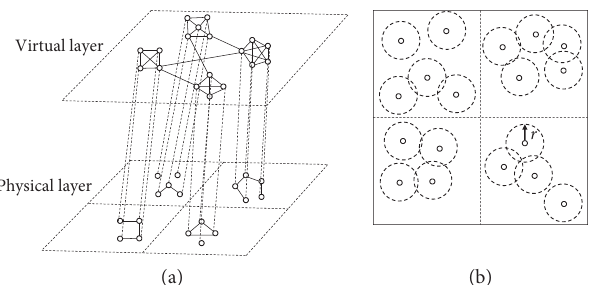
Figure 1: Illustration of multiplex virtual-physical contact network. (a) Virtual contact network with community structure and dynamic physical contact network. (b) Individuals perform random walk in a planar